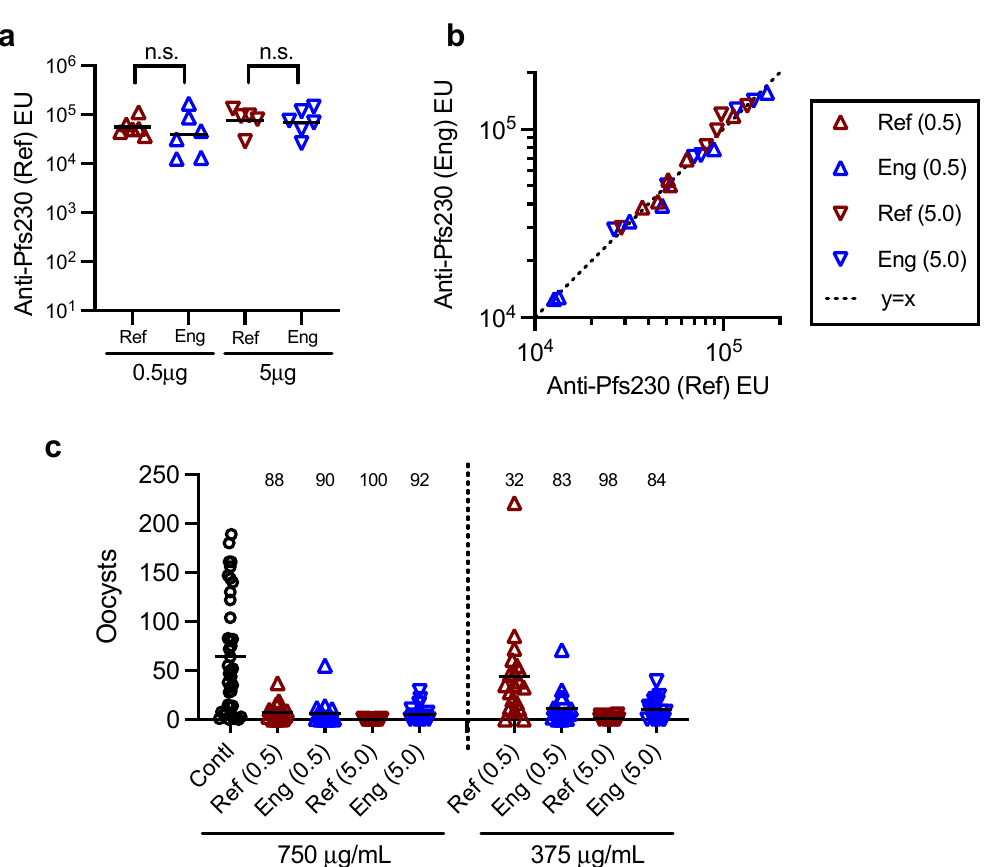
Figure 8. Evaluation for the engineering lot of Pfs230D1+ (Eng). A group of 6 CD-1 mice were immunized with 0.5 or 5 µ g/dose of reference (Ref) or engineering (Eng) lot of Pfs230D1+ protein on days 0 and 21, and serum samples were collected on day 35. ( a ) Anti-Pfs230D1+ ELISA units (EU) against reference protein (Anti-Pfs230 (Ref) EU) were determined by ELISA, and individual (dots) and geometric mean (bars) EU are shown. n.s., not significant ( b ) The same antisera were also tested by ELISA against engineering lot of protein (Anti-Pfs230 (Eng) EU). Anti-Pfs230 (Ref) EU and anti-Pfs230 (Eng) EU of individual sera are shown with a y = x line. ( c ) For each group, total IgG was purified from pooled day 35 sera, and tested by standard membrane-feeding assay at 750 and 375 µg/mL in the presence of complement. As a control (Contl), a total IgG purified from normal mouse sera was tested at 750 µg/mL, and oocyst data in individual mosquitoes are shown with an average (bar) for each group. Percent inhibition in oocyst density (%TRA) was calculated against Contl group, and shown for each group at each concentration.